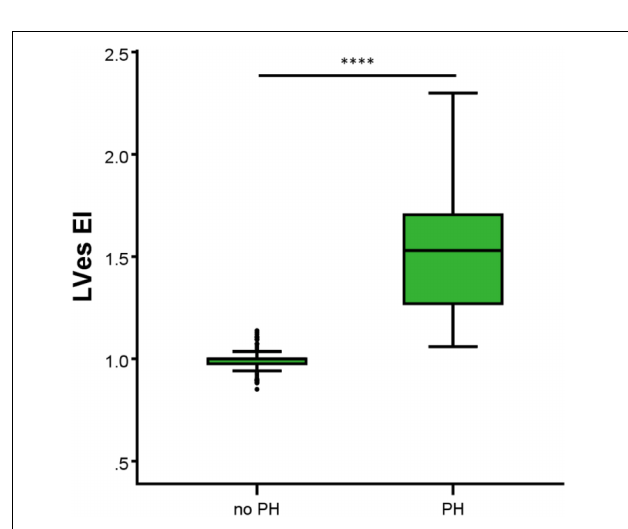
FIGURE 5 | Differences between the healthy study group (no PH) and pulmonary hypertension (PH) study group in LVes EI (left ventricular endsystolic eccentricity index). The box plot graphs show the median, IQR and range (Tukey method 1.5 ∗ IQR). ∗∗∗∗ p < 0.0001.